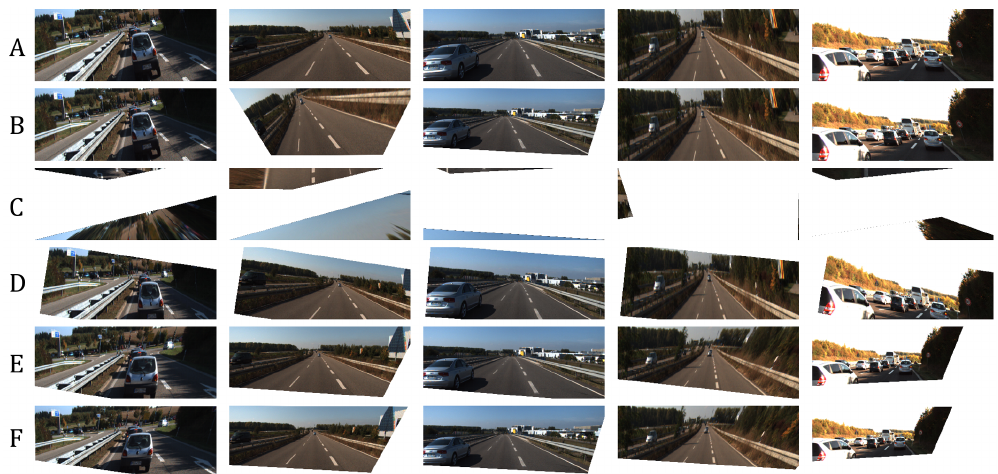
Figure A2. Additional results using unseen data from KITTI. ( A ): Distorted input images. ( B ): Corrected image using homography estimation ( C ): Corrected image using the technique of Chaudhury et al. [21]. ( D ): Corrected image using the technique of Li et al. [11]. ( E ): Corrected image using our method. ( F ): Ground-truth.